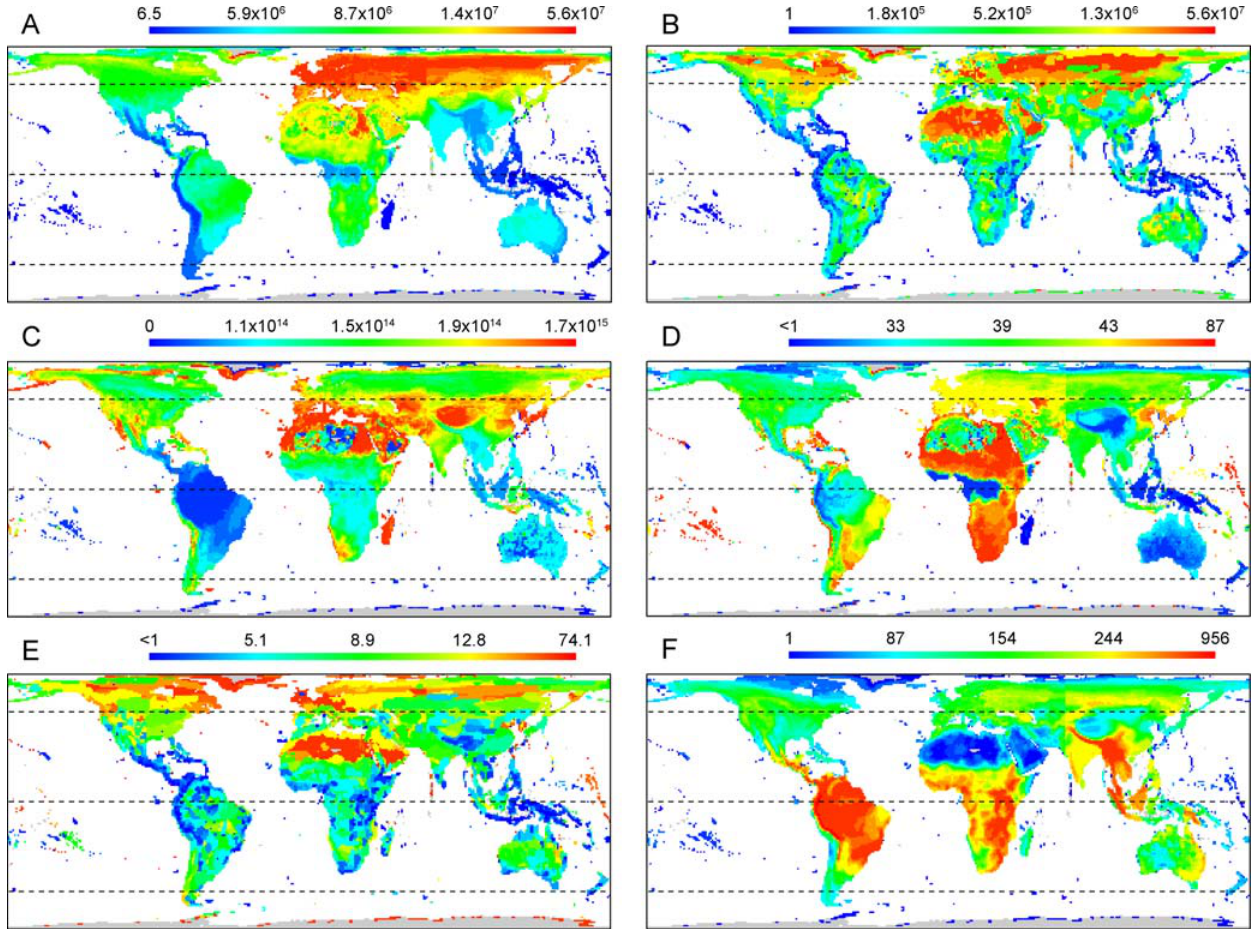
Figure 2. Geographic Distribution of Geographic Range Areas, Latitudinal Range Extent, and Species Richness for the Global Avifauna (A) Median geographic range area (km 2 ). (B) Minimum geographic range area (km 2 ). (C) Variance in geographic range area (km 2 ). (D) Median latitudinal range extent (degrees). (E) Minimum latitudinal range extent (degrees). (F) Total species richness. The map scales are based on quartiles of the underlying distributions; the scale bars show the quartile values for each map. Parallels are shown at 45 8 S, the Equator, and 45 8 N. DOI: 10.1371/journal.pbio.0040208.g002